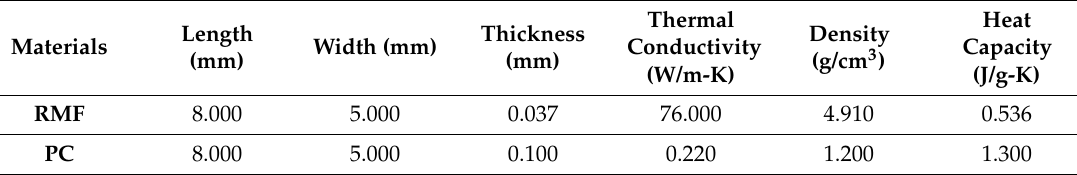
Table 2. ANSYS simulation parameters.